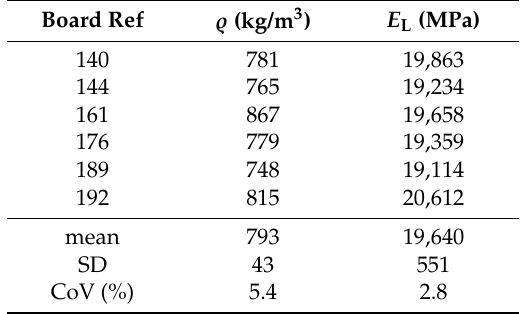
Table 1. Density and elastic modulus of elasticity of Eucalyptus globulus